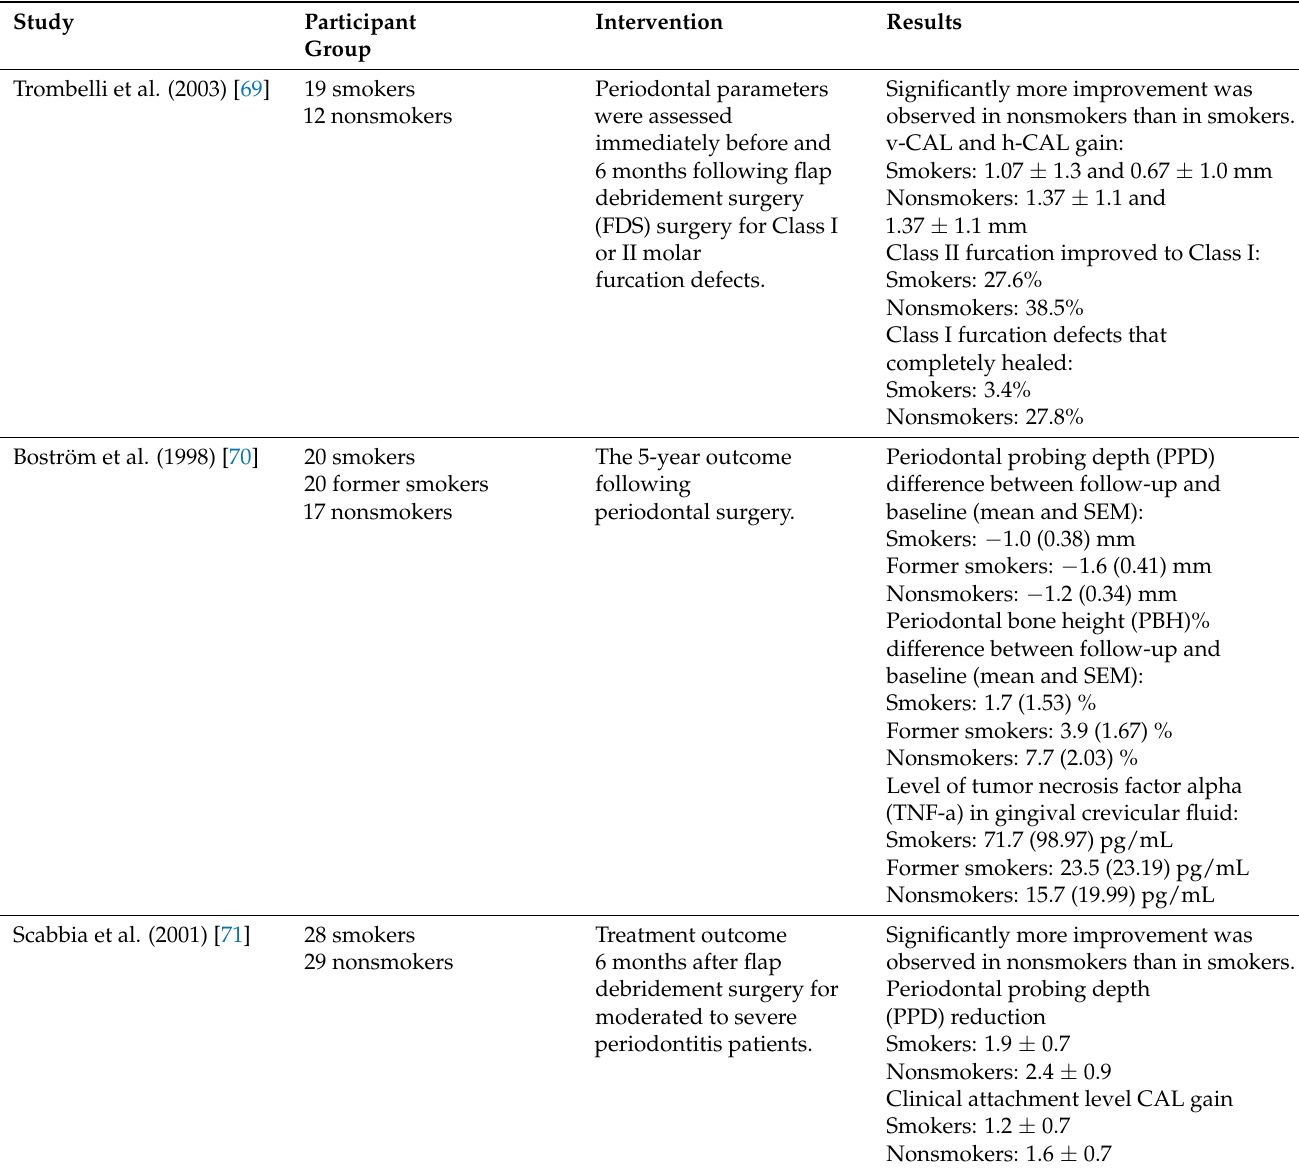
Table 3. Studies which have utilized various periodontal surgical procedures in smoker and non- smoker